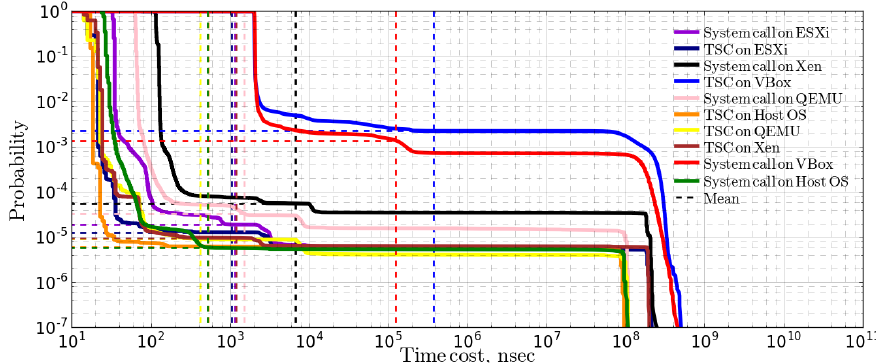
Figure 6. Measurements of timer cost for the CPU testbed on: ( a ) Host OS; ( b ) Xen; ( c ) Virtual Box; ( d ) QEMU; and ( e ) VMware ESXi.